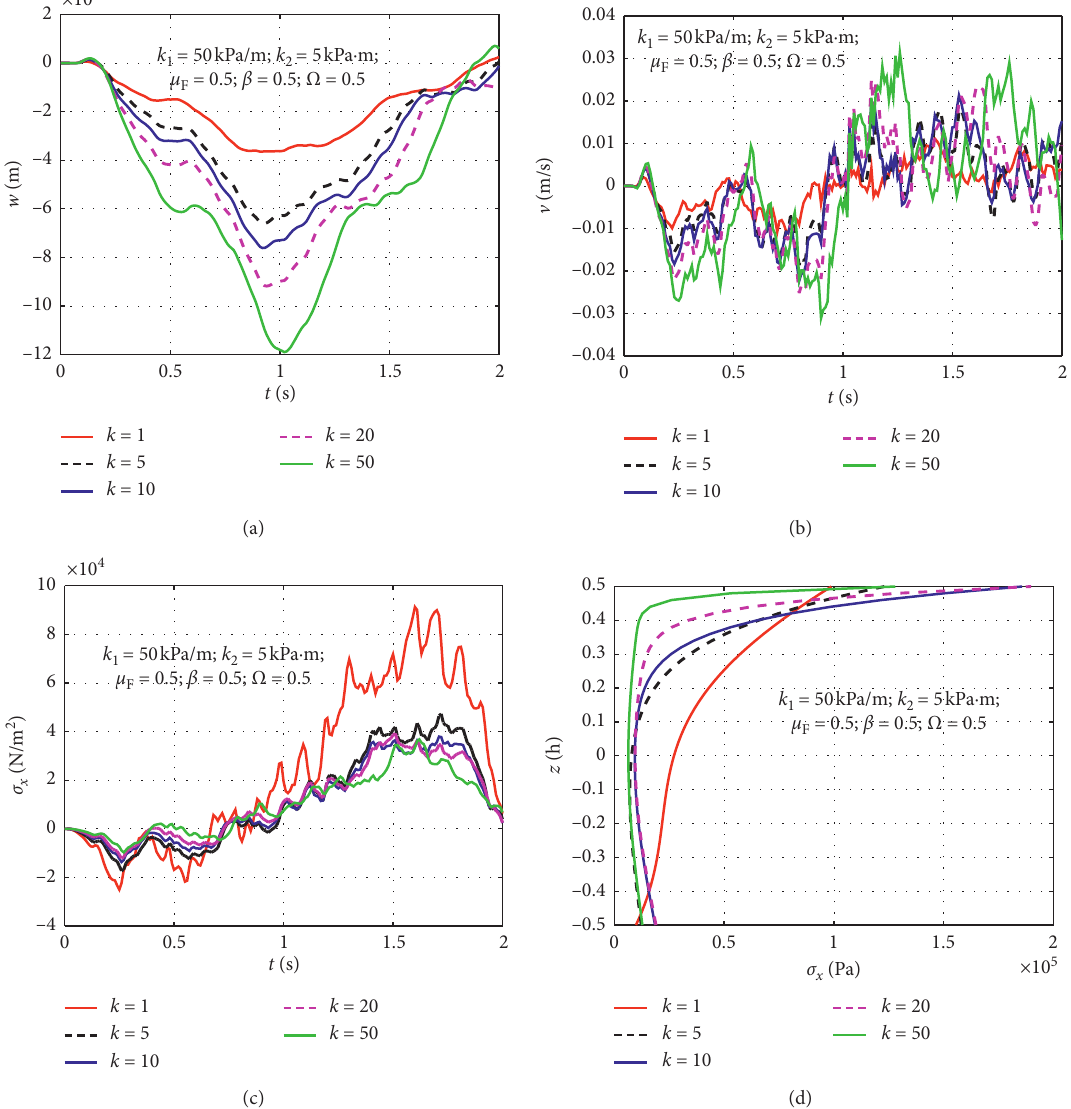
Figure 13: The responses of deflections, velocities, and stresses at the central point of the FGP plate versus time with the variation of the foundation stiffness k : (a) deflection w versus time; (b) velocity v versus time; (c) stress σ x versus time; (d) stress σ x through